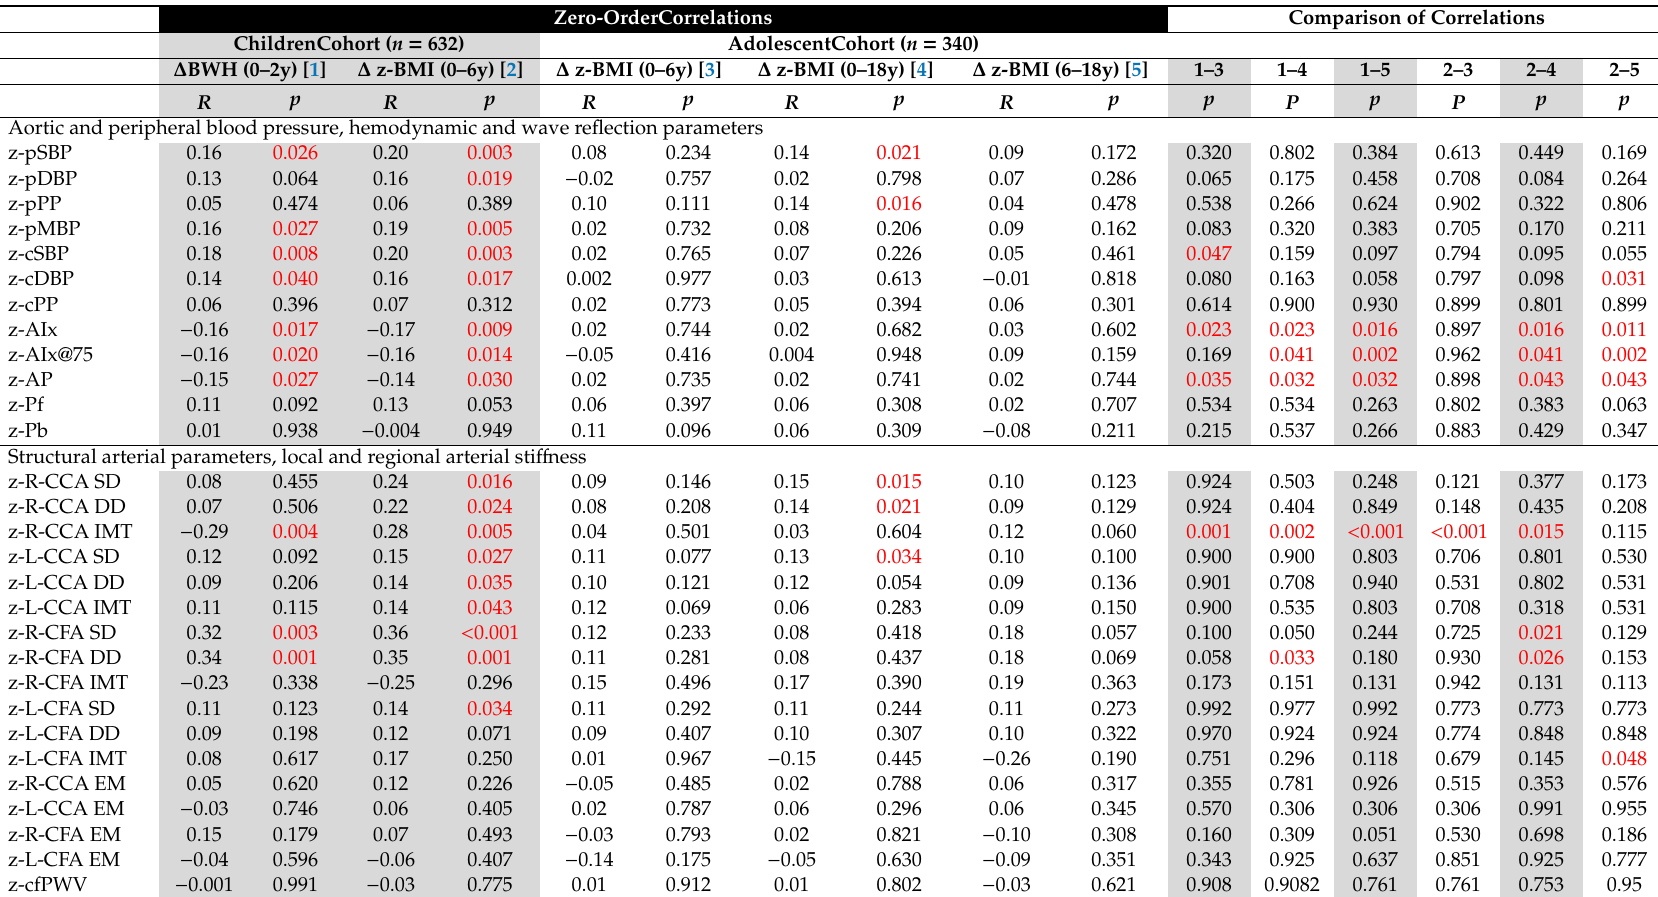
Table 4. Comparative analysis of the associations between CV and anthropometric parameters: children vs.